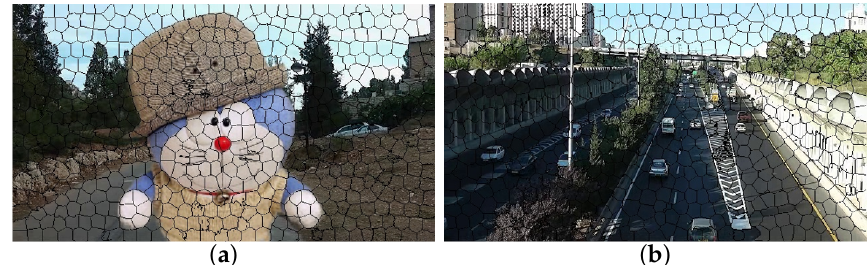
Figure 3. The result of superpixel in two different types of videos: ( a ) large foreground occlusions, ( b )